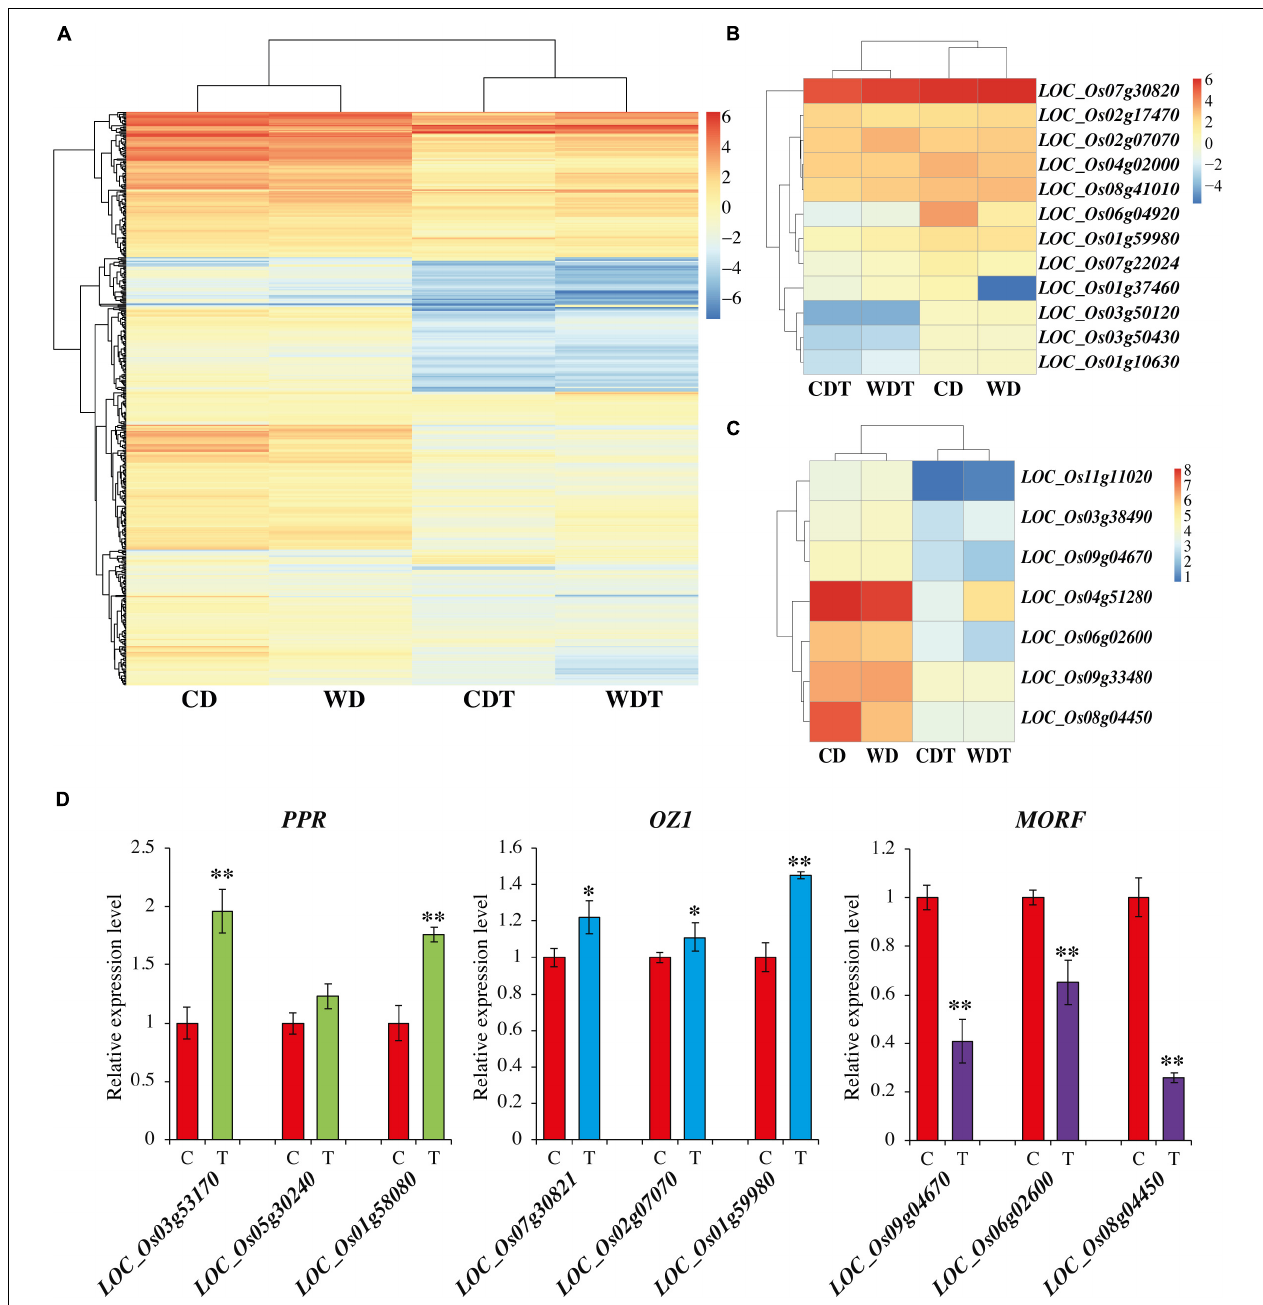
FIGURE 4 | Expression of PPR genes (A) , OZ1 genes (B) , and MORF/RIP genes (C) in two genotypes of rice (CD, Caidao and WD, WD20342) under control and treatment. (D) Expression analysis of PPR , OZ1 , and MORF/RIP genes through qRT-PCR in control (C) and treatment (T). Mean of three replicates with ± SE were used. For comparison t -test was used ( ∗∗ p < 0.01 and ∗ p <